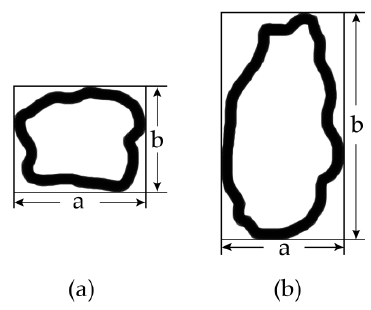
Figure 1. Scrap shapes: ( a ) regular shape; and, ( b ) irregular shape.